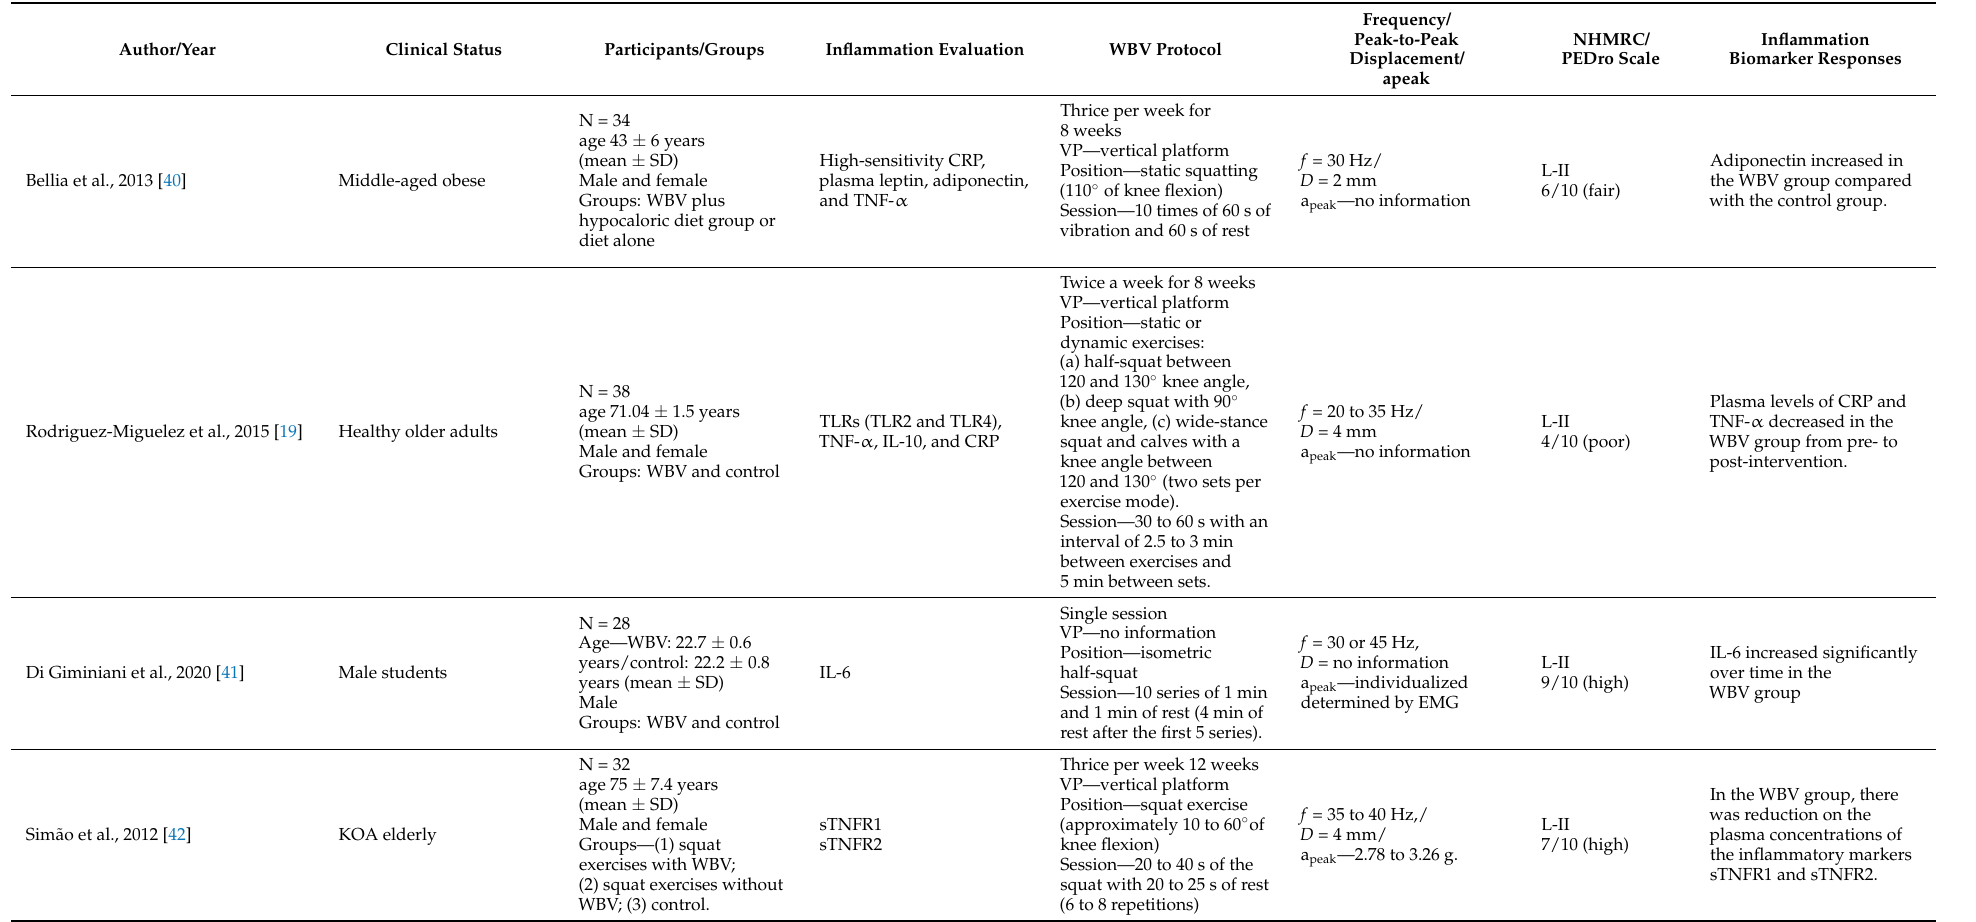
Table 1. Characteristics of the publications included in the current systematic